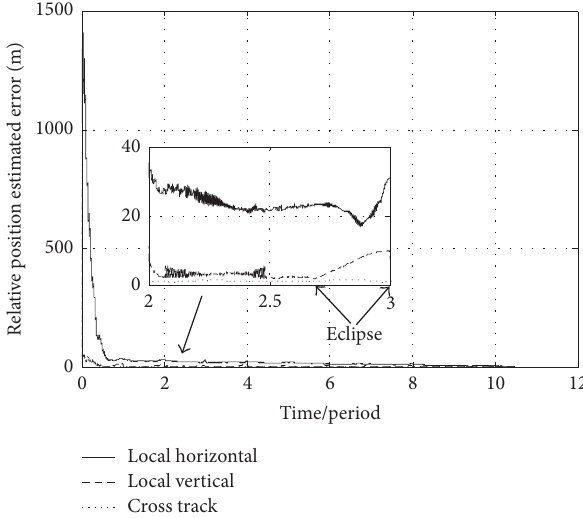
Figure 3: Relative position estimated error variation with 30% eclipse in one-period Monte Carlo shooting.